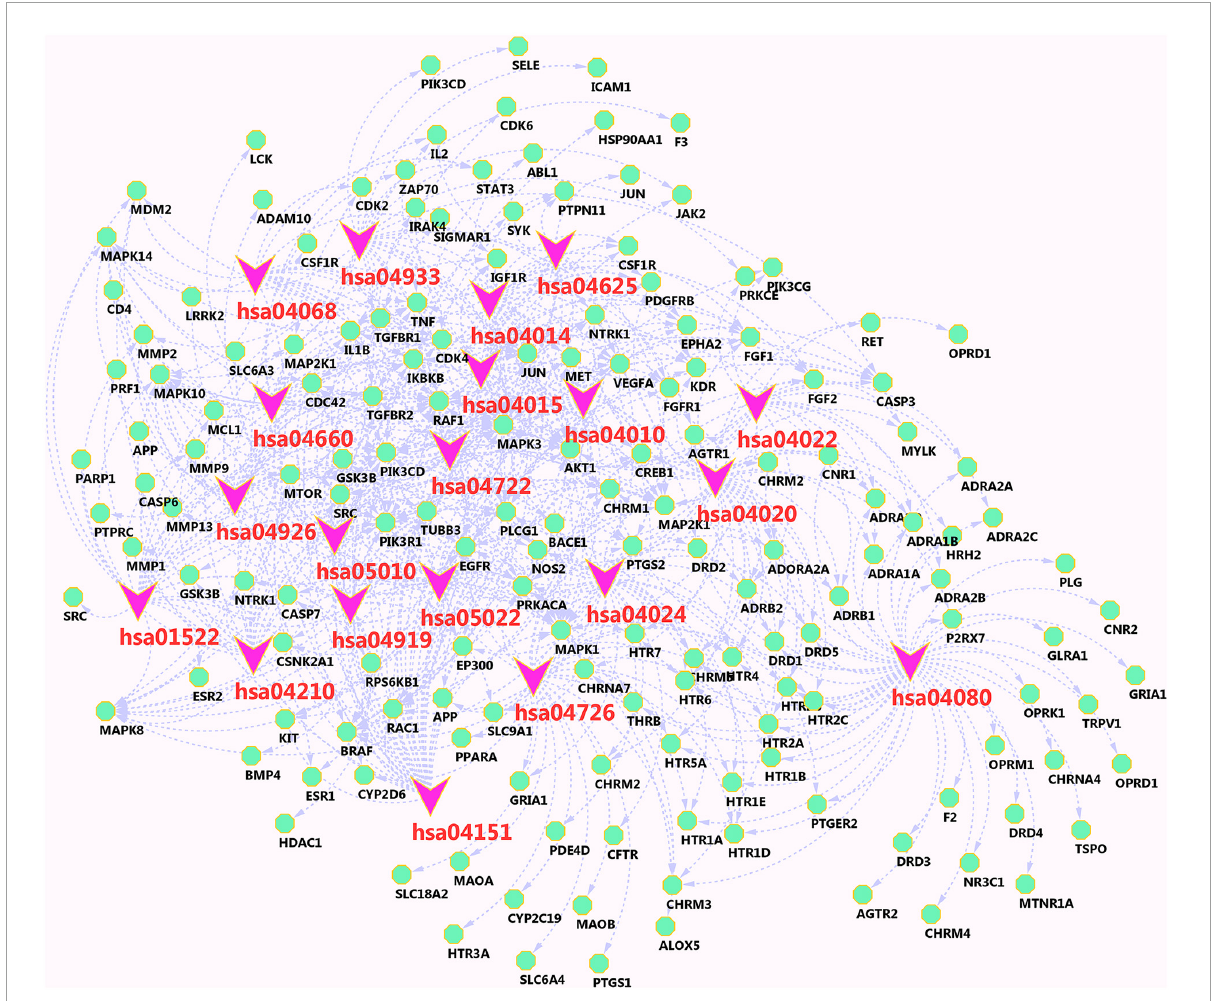
FIGURE10 Passage-target visualization diagram. Pink nodes are pathways, and green nodes are related target